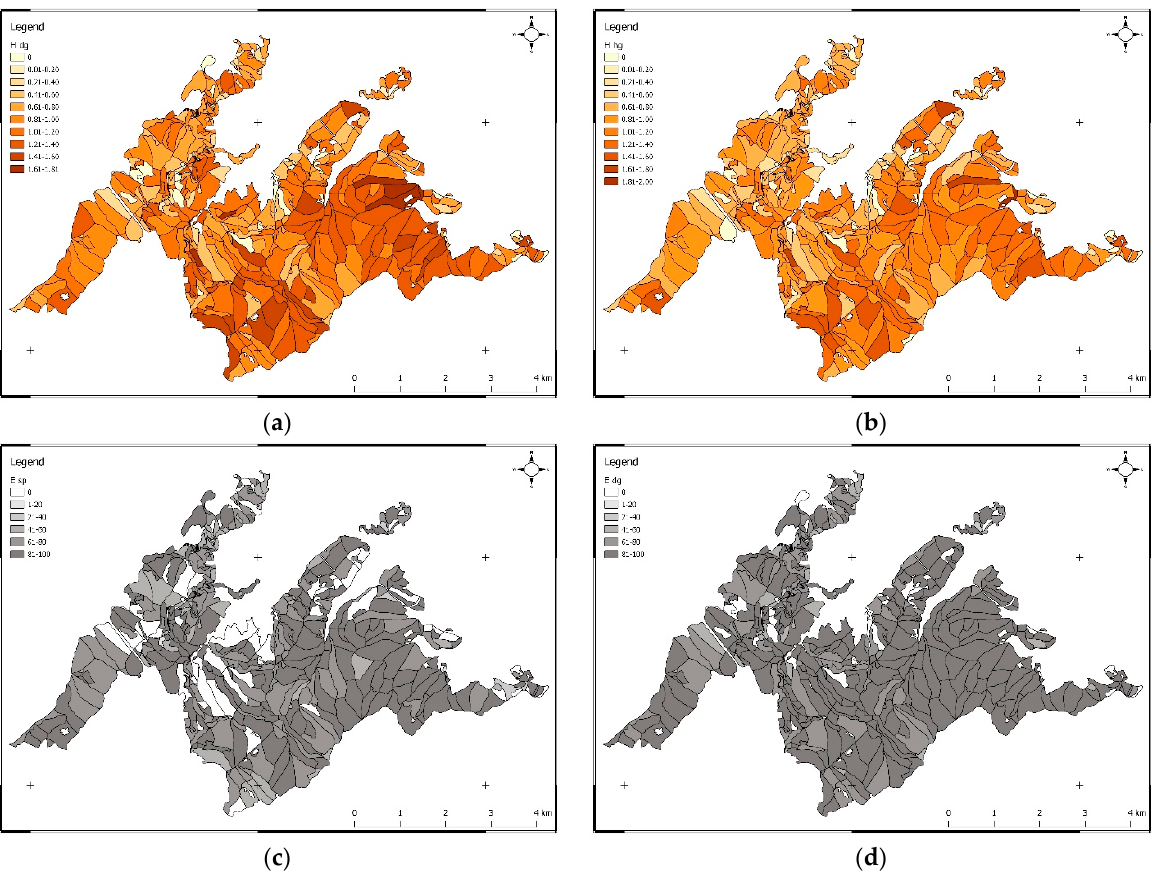
Figure 8. Stand distribution maps in relation to the ( a ) Hd g values, ( b ) Hh g values, ( c ) Esp. distribu- tion, and ( d ) Ed g values.